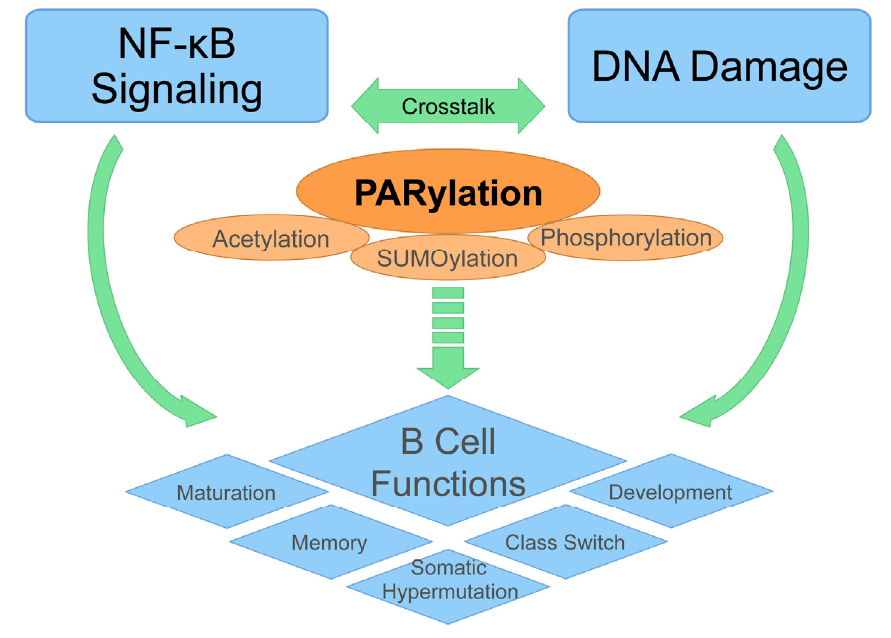
Figure 2. Poly-ADP-ribosylation (PARylation) in B cell development, differentiation, and maturation. DNA damage repair and NF- κ B activity are known to be critical during B